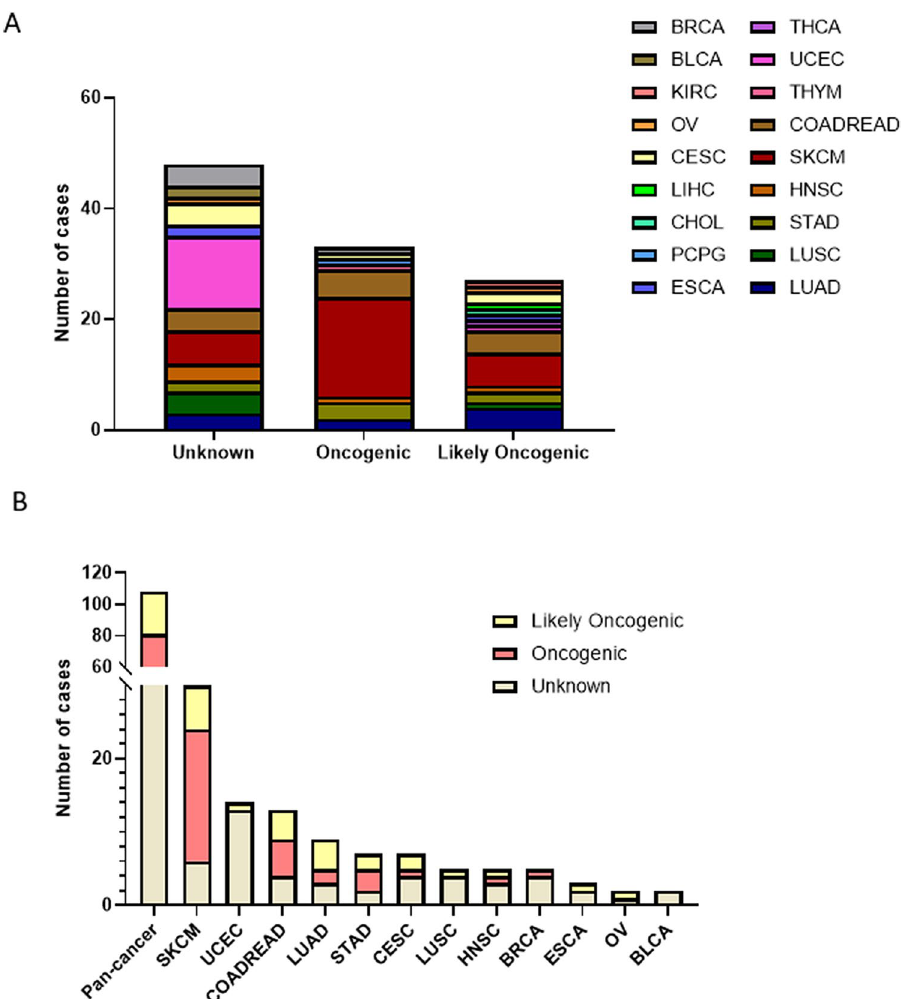
Figure 3. MEK1 mutation classification based on the functional impact. ( A ) MEK1 mutation classification based on the functional impact in pancancer. ( B ) MEK1 mutation classification based on the functional impact on all and top 12